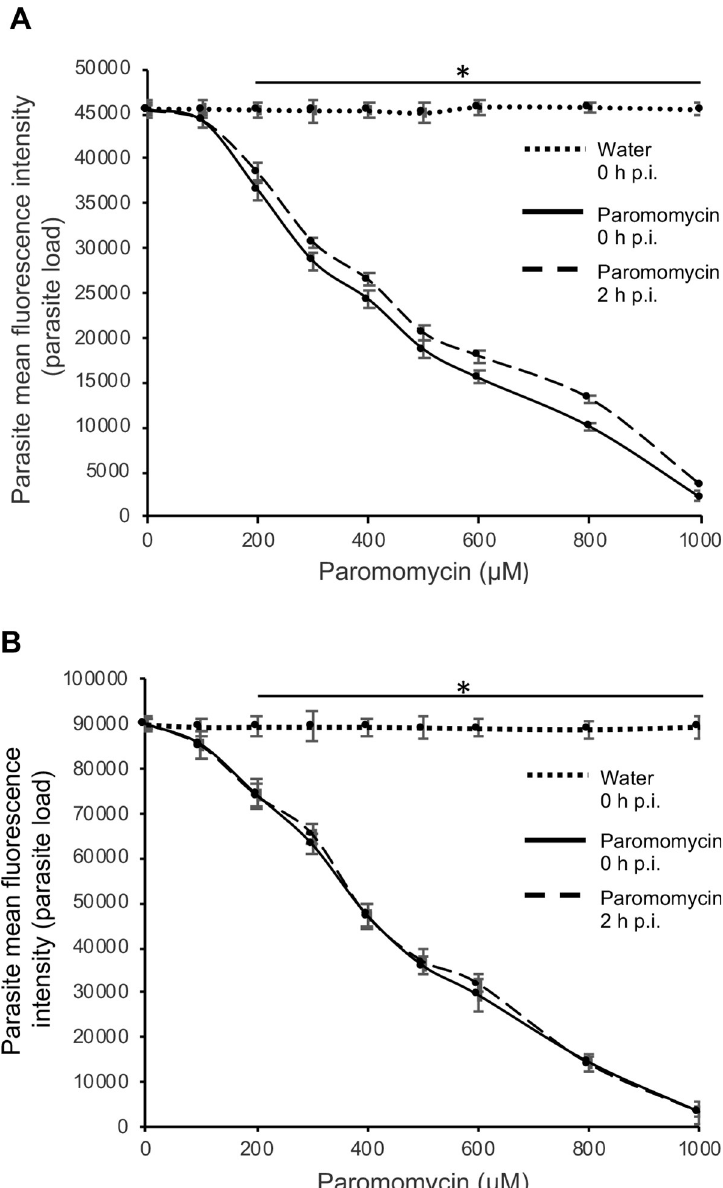
Fig 6. Analysis of the effect of varying concentrations of paromomycin on the growth of Cryptosporidium parvum in HCT-8 cells. Equal amounts of freshly excysted sporozoites of C . parvum were inoculated into HCT-8 cells in culture and varying concentrations of paromomycin dissolved in sterile distilled water was added at infection (solid line) or 2 h post-infection (p.i.) (dashed line). Control infected cells (dotted line) were treated immediately p.i. with volumes of sterile distilled water equivalent to those used in the paromomycin-treated cultures. The cultures were analyzed for parasite infectivity and proliferation by an immunofluorescence assay after (A) 48 h, and (B) 72 h of culture. The fluorescence generated by intracellular C . parvum merozoites was quantified and is shown on the Y -axis representing the parasite load. The data shown represent means of three independent experiments with standard error bars and levels of statistical significance between groups indicated by asterisk ( � , P <